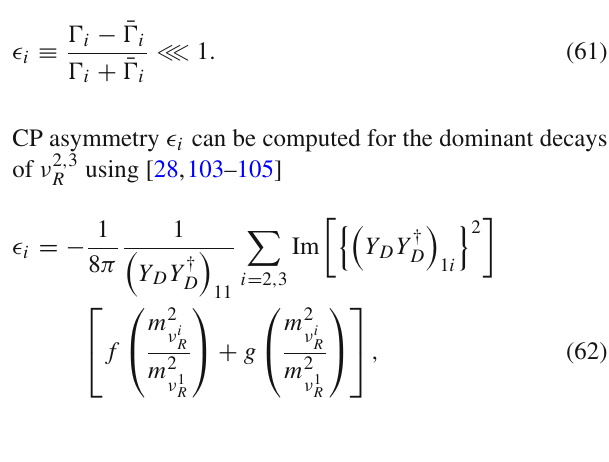
Fig. 3 In this plot we depict the reheating temperatures T R Vs. m ϕ for ∼ 10 − 8 − 10 − the values of couplings Y 2 , 3 N